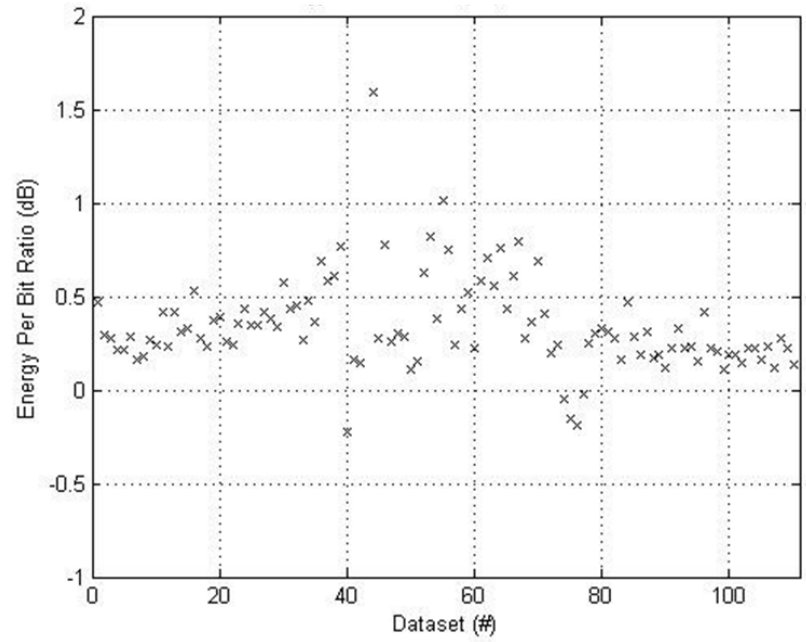
Figure 9. Energy per Bit ratio for M = 100 vs. M = 0. Note that the proposed system exhibits an average 0.4 dB increase in energy per